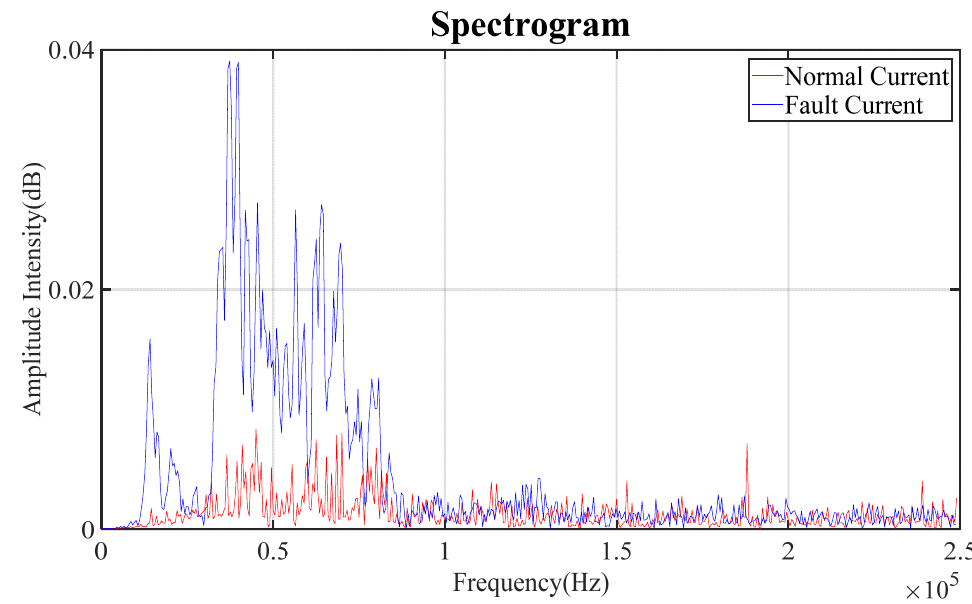
Figure 9. The comparison of current waveforms in the frequency-domain.